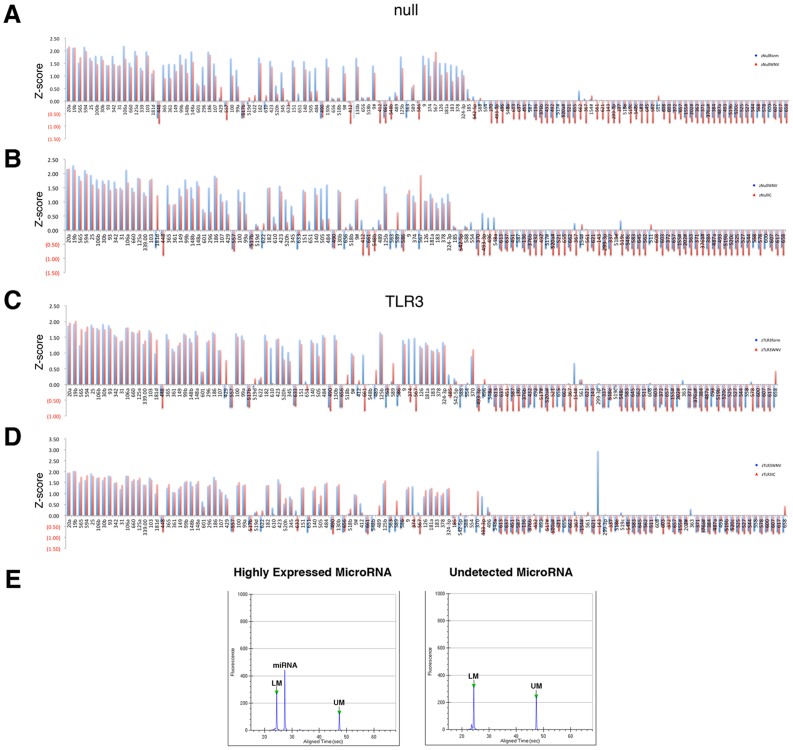
Directed Comparison of abundant miRNAs.All miRNAs with at least one data point had a CT≤28 were selected, normalized to stable small RNAs, and the median CT across the 2, 4, and 8 hr time point was calculated. These were further standardized to yield a Z score, which reflects relative changes. The Z score is shown on the vertical axis and miRNAs on the horizontal axis. The Z scores were ordered by the level of uninfected HEK293-Null (A, B) or HEK293-TLR3 (C, D) cells. Panels (A) and (C) compare the response of WNV to formalin-inactivated virus. Panels (B) and (D) compare the response of WNV infection to polyI:C stimulation. (E) Caliper LabChip analysis of a highly expressed and undetected miRNA. qPCR products of miRNA assays were run on a Caliper LabChip GX and the resulting electropheregram is shown. The sample yields a single peak corresponding to the expressed miRNA and two assay marker bands (UM – upper marker and LM – lower marker). The undetected miRNA electropheregram shows only an upper and lower marker peak with very little to no background signal, confirming the high specificity of this assay.